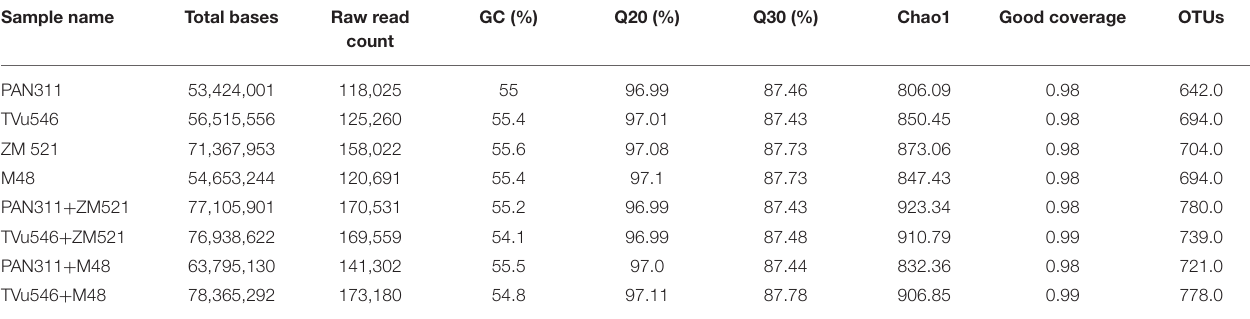
TABLE 1 | Information about number of generated raw sequences, quality sequences, chao1, and